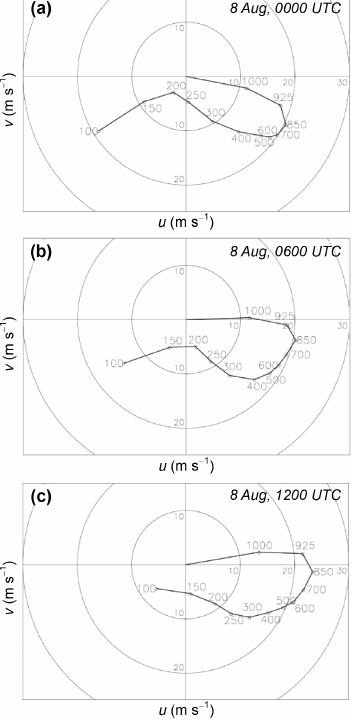
Figure 5. Hodograph of the mean wind (ms − 1 ) inside 22– 24 ◦ N, 118.3–121 ◦ E (brown dashed box in Fig. 3a) computed from the ECMWF-YOTC analyses at (a) 00:00, (b) 06:00, and (c) 12:00UTC, 8 August 2009. The numbers along the curve in- dicate pressure (hPa) at nearby dots.